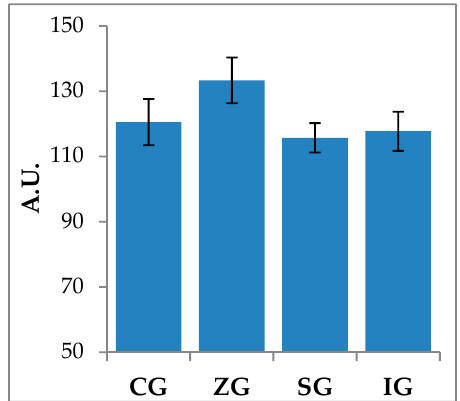
Figure 2. Casein-zymography on milk samples obtained from lactating dairy cows fed control diet (CG) and control diet supplemented with zinc (ZG), selenium (SG), and iodine (IG). The ImageJ software was used to perform the quantitative analysis. Data are reported as mean values expressed in arbitrary unit (A.U.) ± standard deviation.